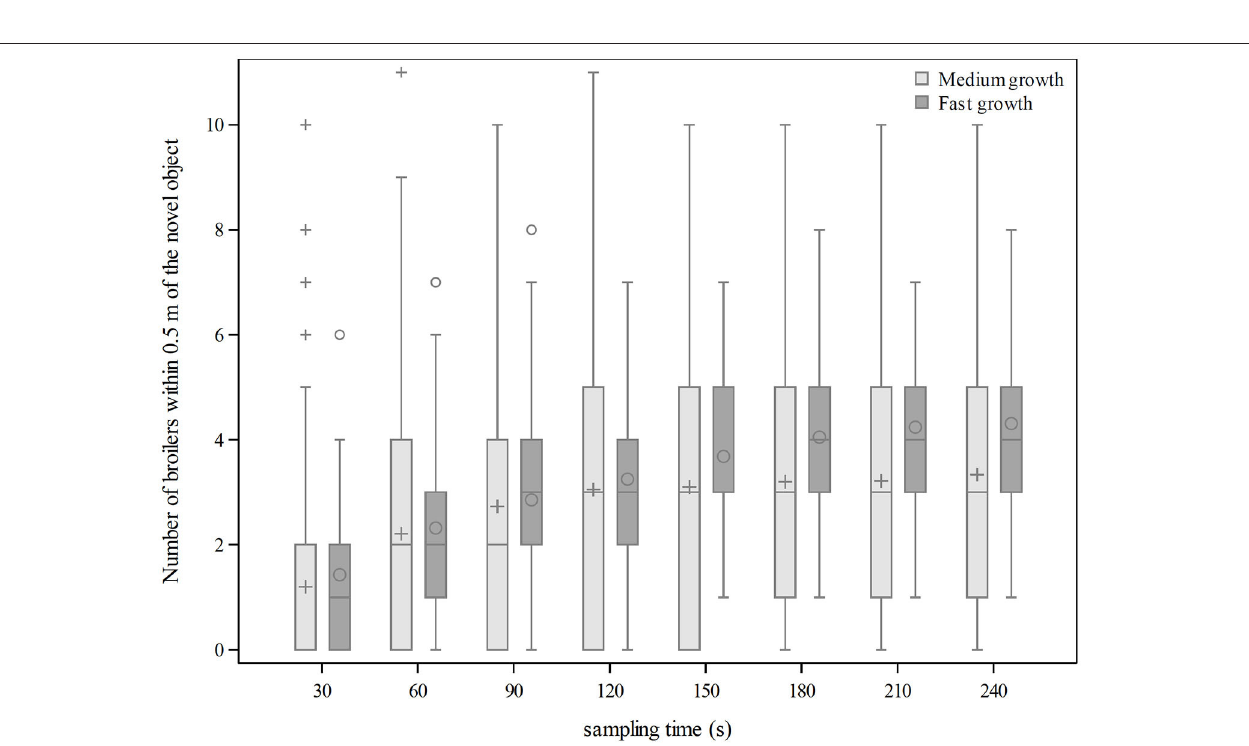
FIGURE 3 | Interaction between the genetic strain and the sampling time on the number of broilers within 0.5m of the novel object. Boxes show interquartile ranges, and whiskers represent minimum and maximum values. Symbols ( + , ◦ ) inside boxes indicate the mean value, while symbols ( + , ◦ ) outside whiskers represent outliers.